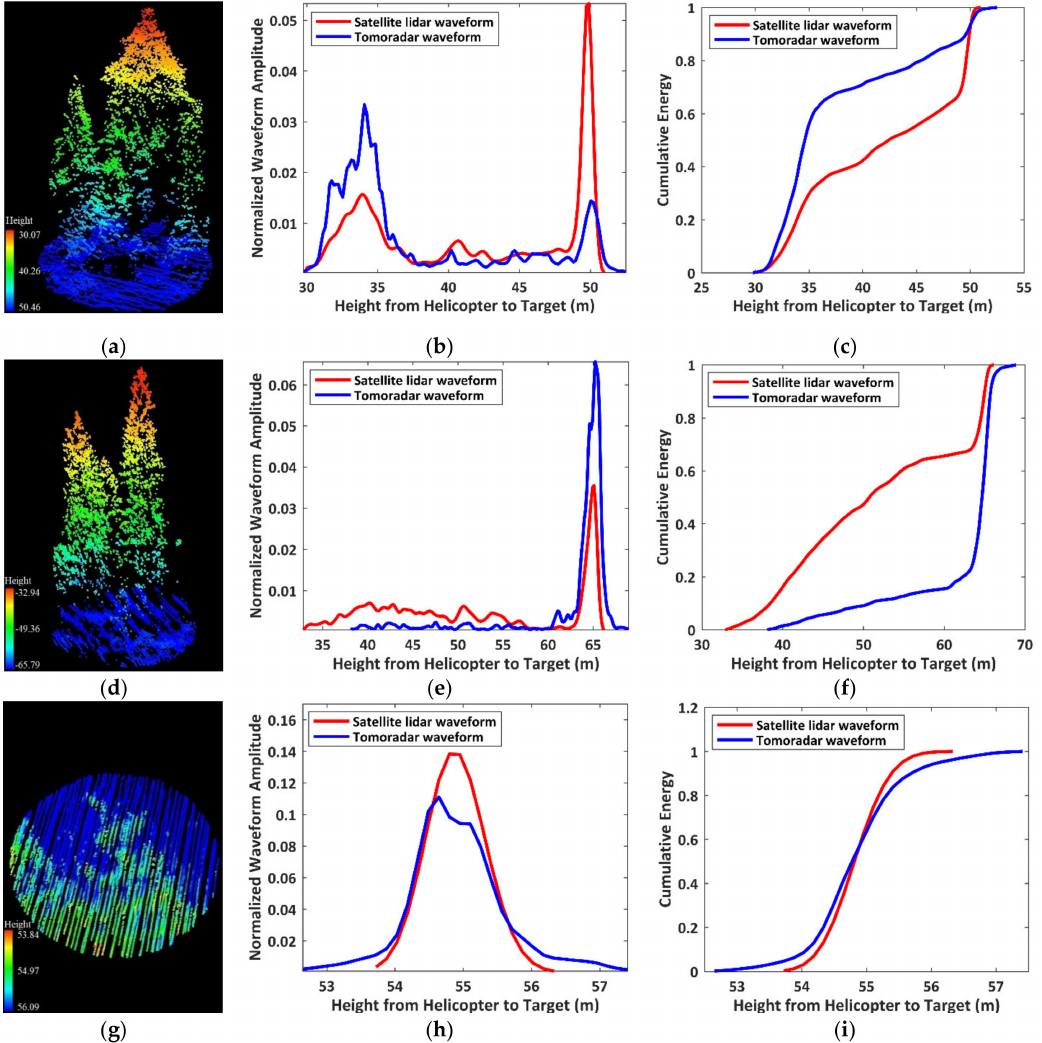
Figure 7. The point cloud of the target within the footprint (left) and the waveforms (middle) and cumulative energies of Tomoradar and satellite lidar (right) of three typical situations from the top row to bottom row: ( a – c ) the case that HP t is much larger than HP l ; ( d – f ) the case that HP t is much smaller than HP l ; ( g – i ) the case that HP t is approximately equal to HP l